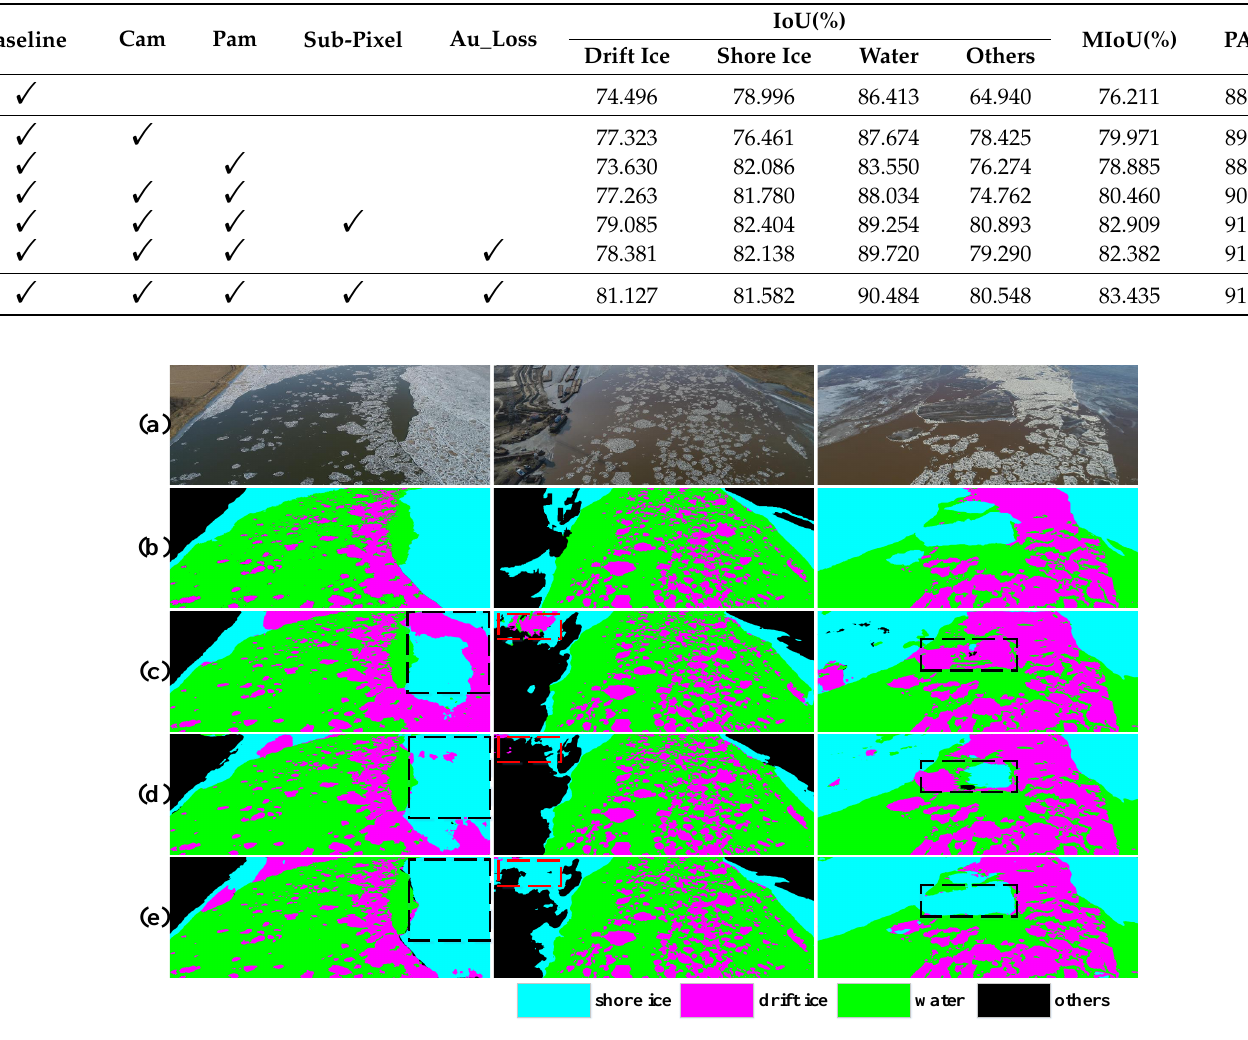
Figure 9. Visualization results of ablation study. ( a , b ) respectively represents the images and the corresponding labels. ( c ) represents the results obtained through the baseline model. ( d ) is the results of adding both PAM and CAM modules. ( e ) represents the prediction obtained by adding all sub-modules of the ablation